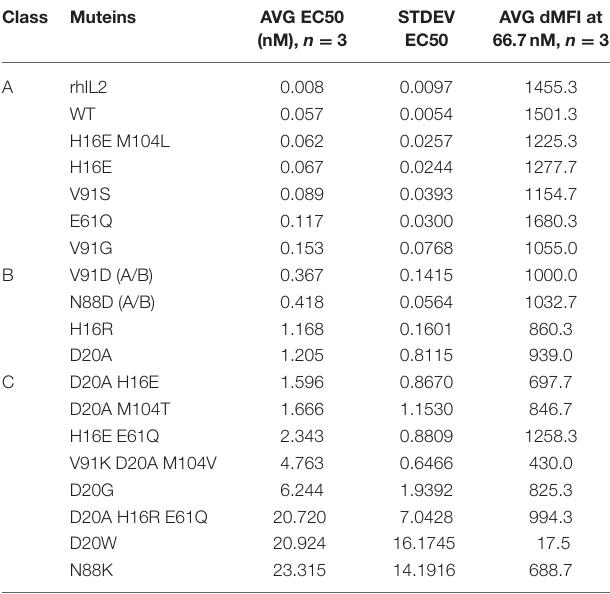
TABLE 1 | Mutein classification based on the pSTAT5 MFI EC50